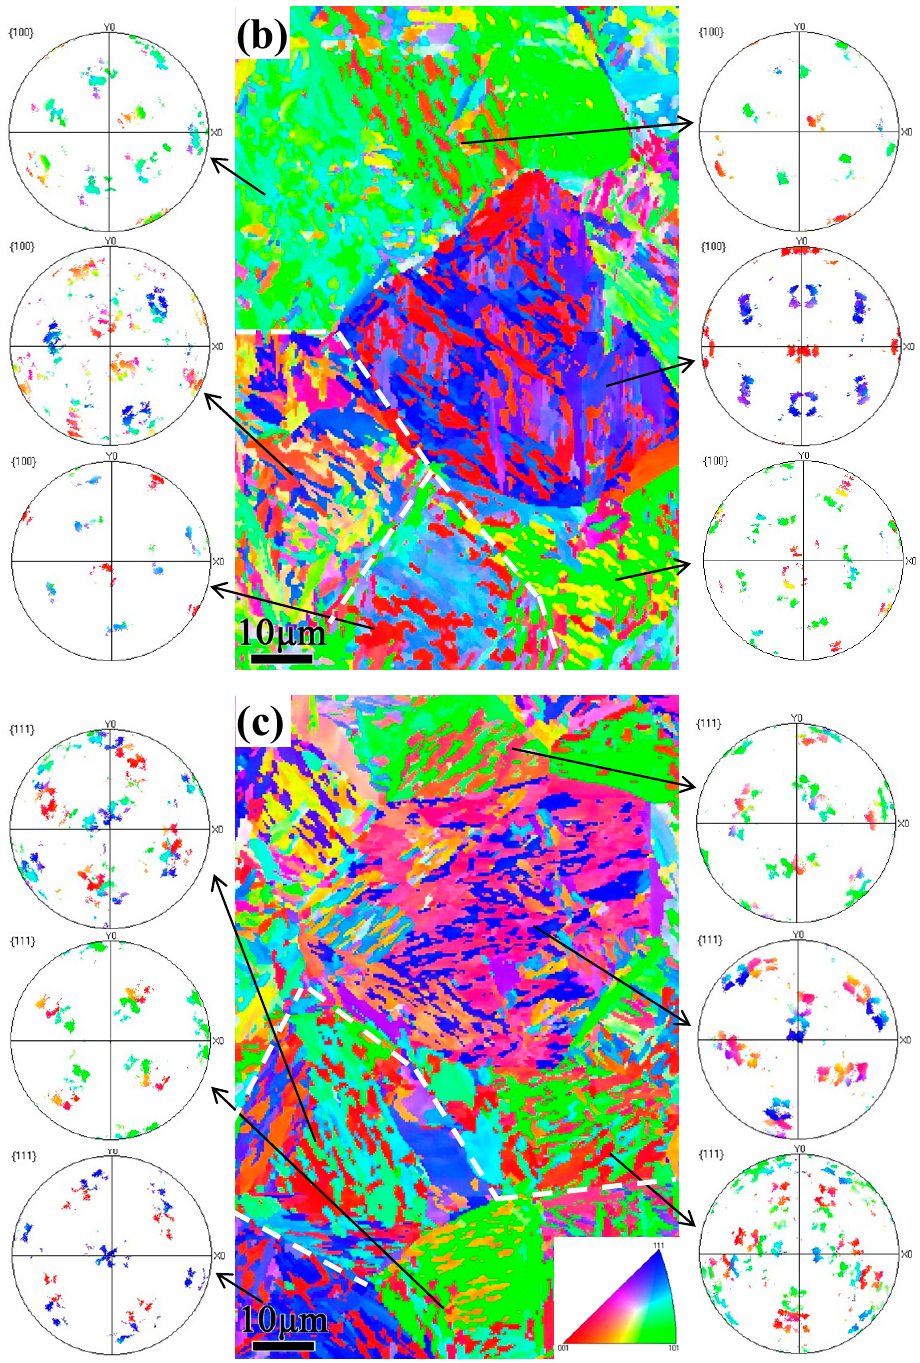
Figure 7. Inverse pole figure maps and the corresponding pole figures of each grain at different quenching temperatures followed by annealing at 600 °C: ( a ) 120 °C, ( b ) 150 °C and ( c ) 190 °C. White lines mainly indicate the selected area of the PF subset. The nodules include the structures of tempered martensite and pearlite colonies.